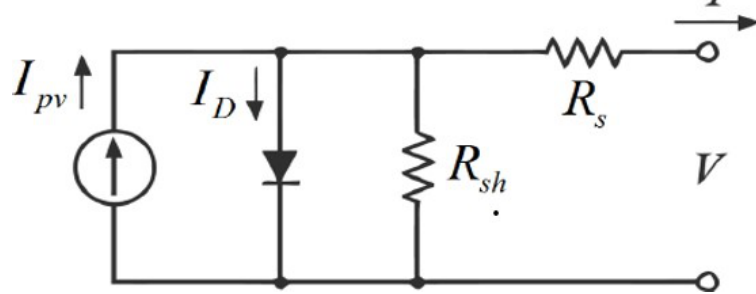
Figure 5. Equivalent circuit of a solar